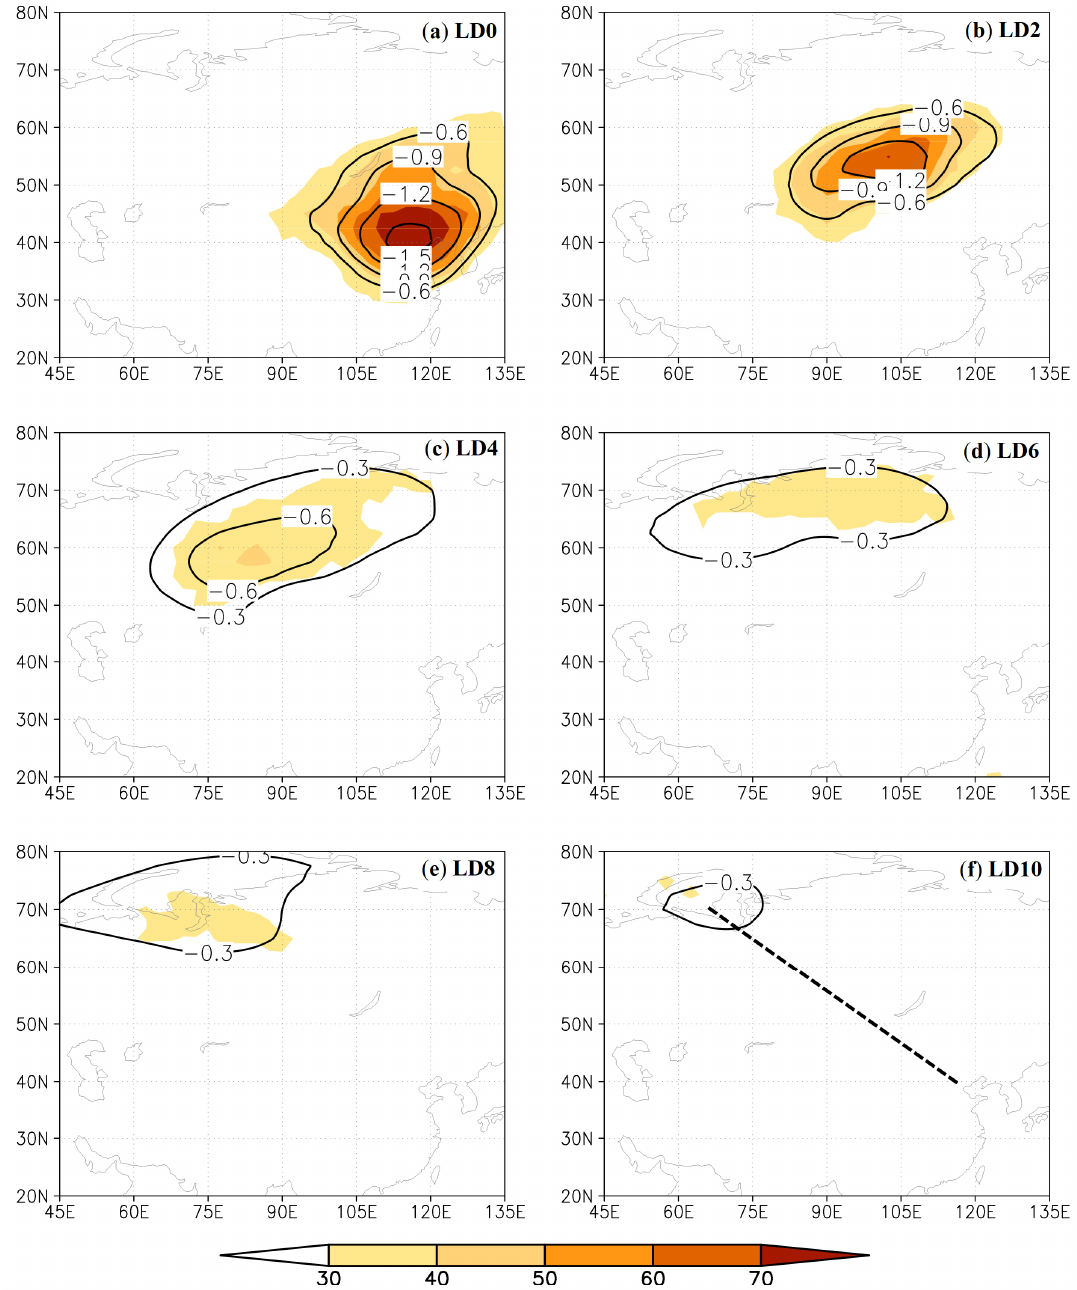
Figure 7. Composites of the normalized temperatures (contours, only below − 0.3 are shown) and probabilities of the normalization below − 1 (shadings, only above 30% are shown, unit: %) at 850 hPa on all the ECS-occurring days; ( a ) 2 days ( b ), 4 days ( c ), 6 days ( d ), 8 days ( e ) and 10 days ( f ) prior to the occurrence at the competition zones of BJ2022. The dashed line in ( f ) denotes the cross-sectional path of the subsequent analysis in Figure